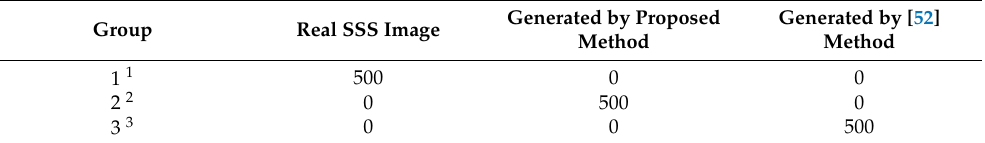
Table 4. Composition of training set.